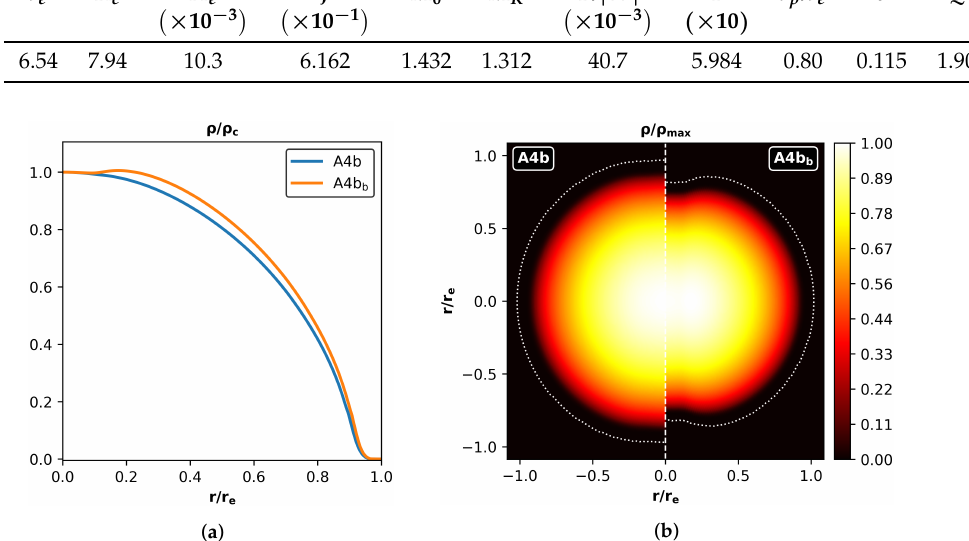
Figure 3. Rest mass density vs. radius ( a ) and two-dimensional rest mass density distribution ( b ) for models A4b and A4b b . Values of the rest mass density are relative to the central value in Figure ( a ) and to the maximum value in Figure ( b ), while values of the radii are relative to the equatorial radius. The left (right) side of Figure ( b ) show the distribution for model A4b (A4b b ). The white dotted lines are the surface of the stars.